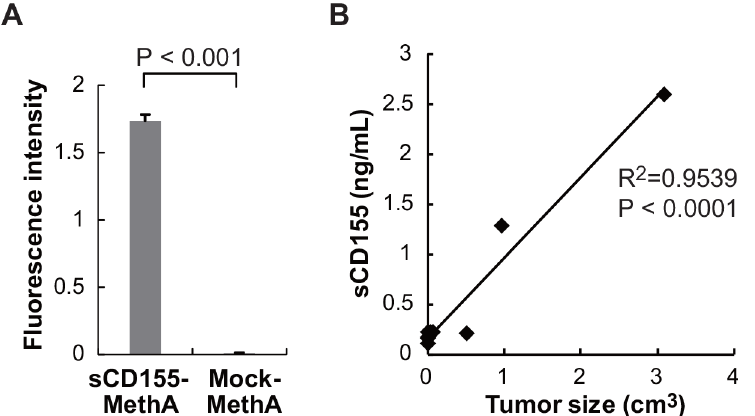
S1 Fig. Establishment of sandwich ELISA for sCD155. ( A ) Standard curve of human CD155-Fc fusion protein. ( B ) In a 12-well plate, 1 × 10 6 HeLa were cultured per 1 mL of medium; culture supernatants were collected after 24 and 48 h for soluble CD155 protein